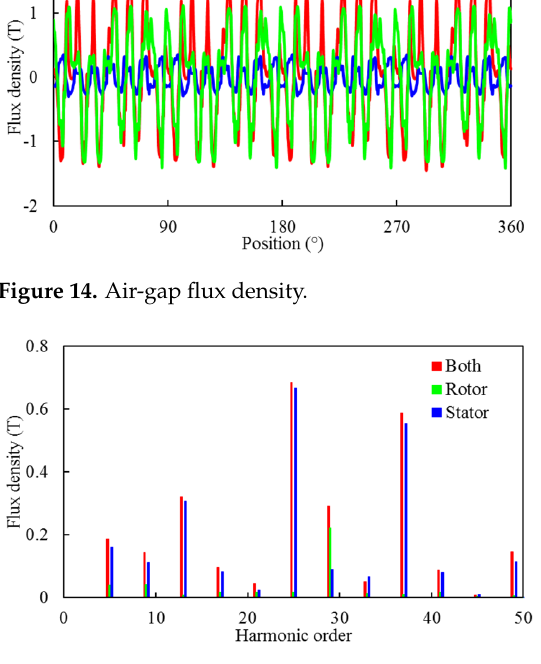
Figure 15. Harmonic spectra of air-gap flux density.